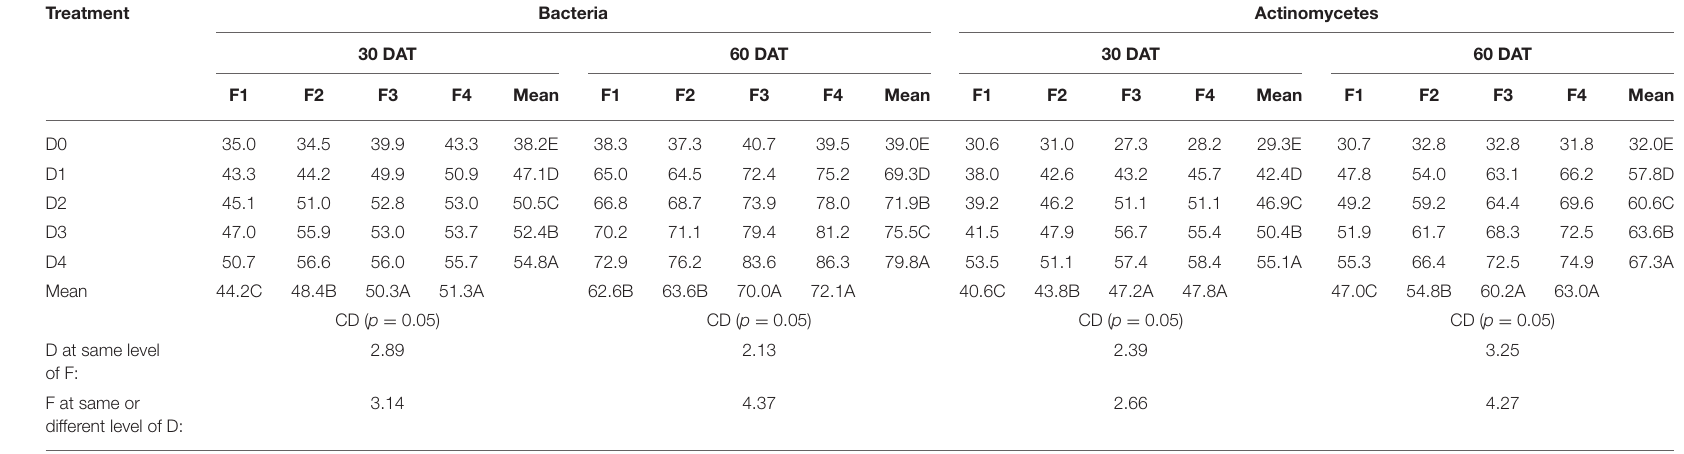
TABLE 7 | Interaction effect of RDF and panchagavya on bacterial and actinomycetes population (cfu) at 30 and 60 DAT. Treatment Bacteria